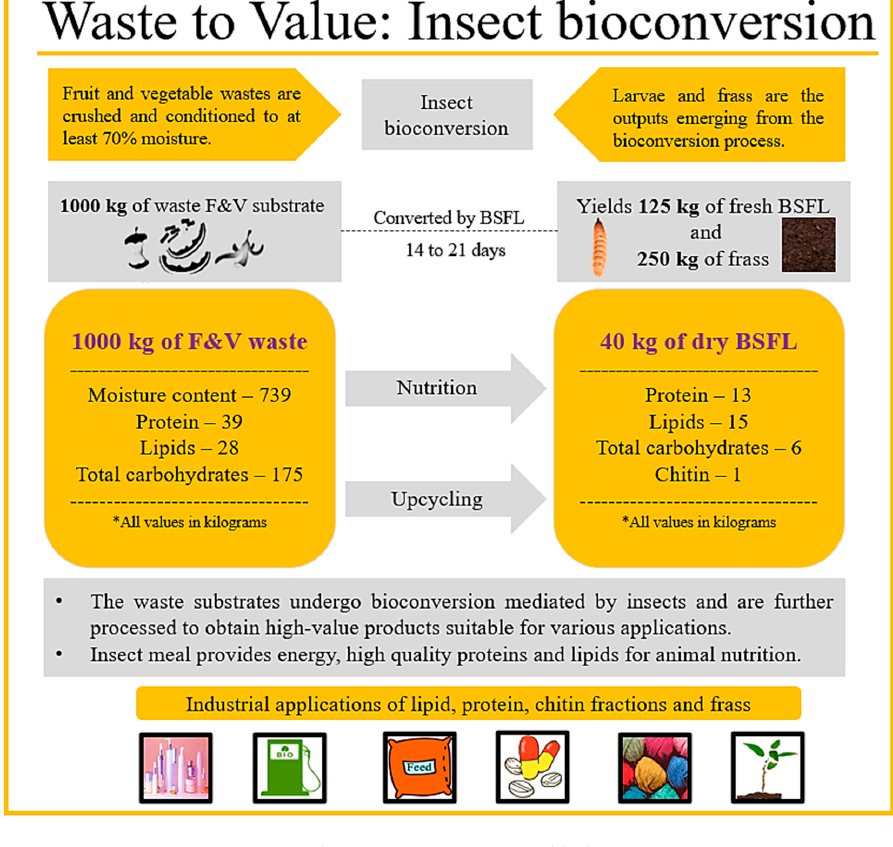
Figure 3. Insect bioconversion: material balance overview.